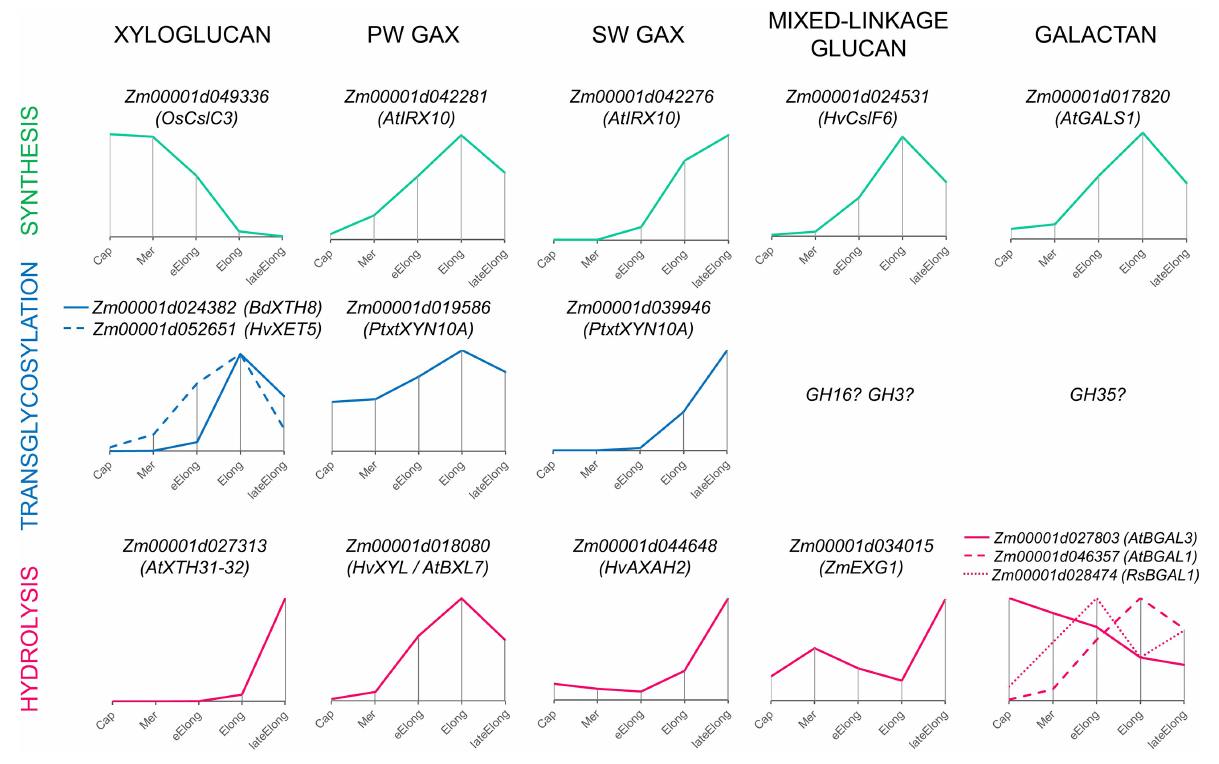
FIGURE 9 | Expression patterns of genes encoding enzymes that can mediate the synthesis, transglycosylation, and hydrolysis of cell wall matrix polysaccharides observed in growing maize roots. Only one gene representing a particular clade or family with the typical dynamics of transcript abundance is shown. The closest characterized homolog for each maize gene is indicated in parenthesis. All profiles are normalized to maximum. Cap, root cap; Mer, meristem; eElong, early elongation zone; Elong, elongation zone; lateElong, late elongation zone; PW, primary cell wall; SW, secondary cell